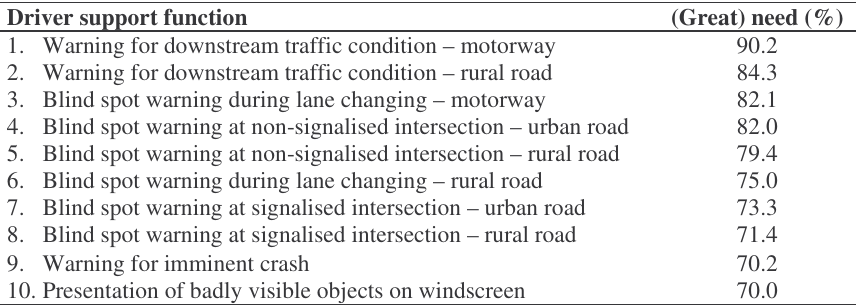
Table 3. Top 10 of most popular driver support functions Driver support